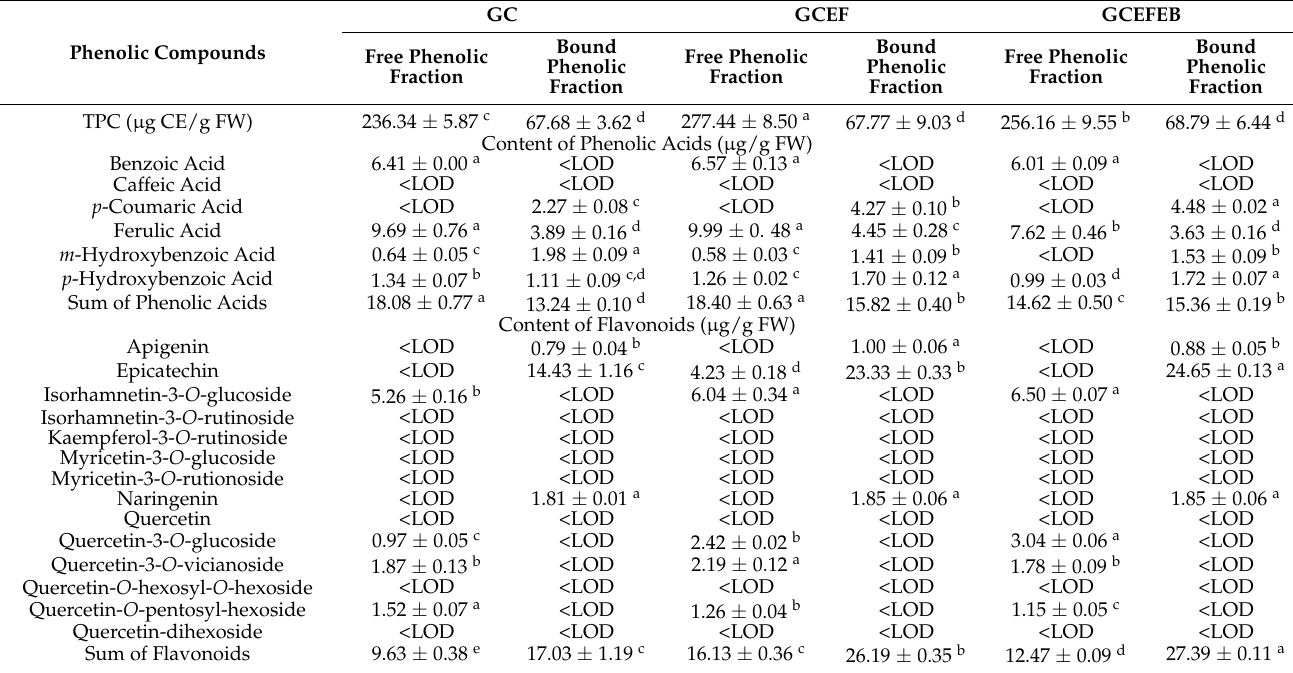
n = 3; x ± SD —mean value ± standard deviation; LOD—limit of detection; different letters ( a–e ) within the same line indicate significant differences (one-way ANOVA and Tukey’s test, p ≤